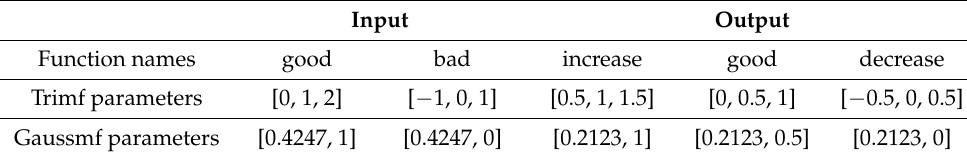
Table 3. Variable range of the membership Table 4. Trial 1 iteration of four driving scenarios, using the fuzzy logic controller with linear mem- bership function.